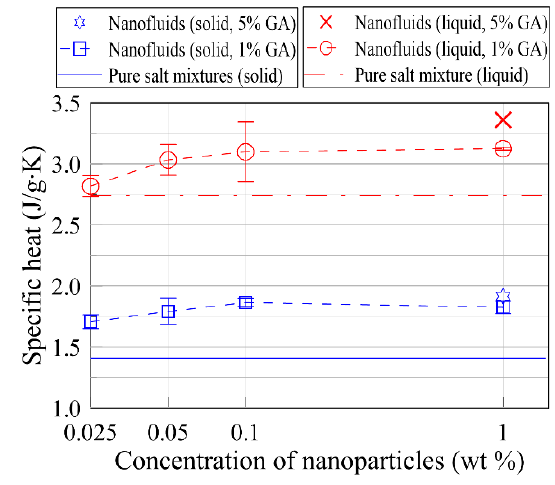
Figure 7. Specific heat of nanofluids in the solid and liquid phases with respect to the nanoparticle